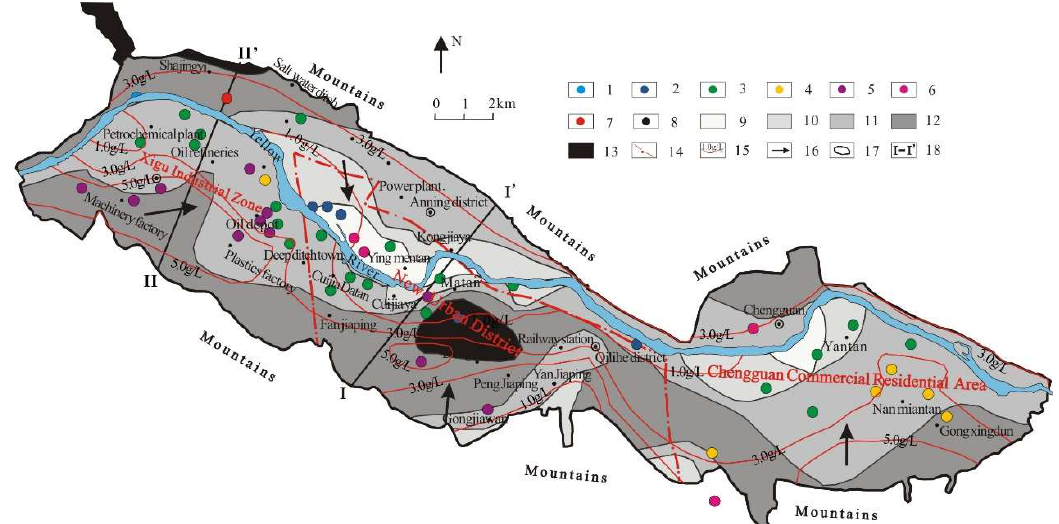
Figure 6. Comparison of hydrochemical type distribution in 1980 and 2012 in the study area